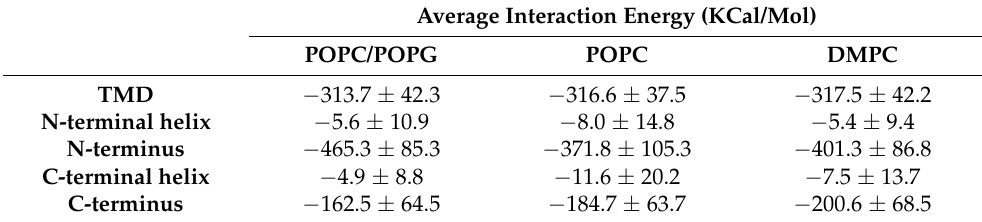
Table 2. Average interaction energy calculated from the interaction energy shown in Figure 8. The error represents standard